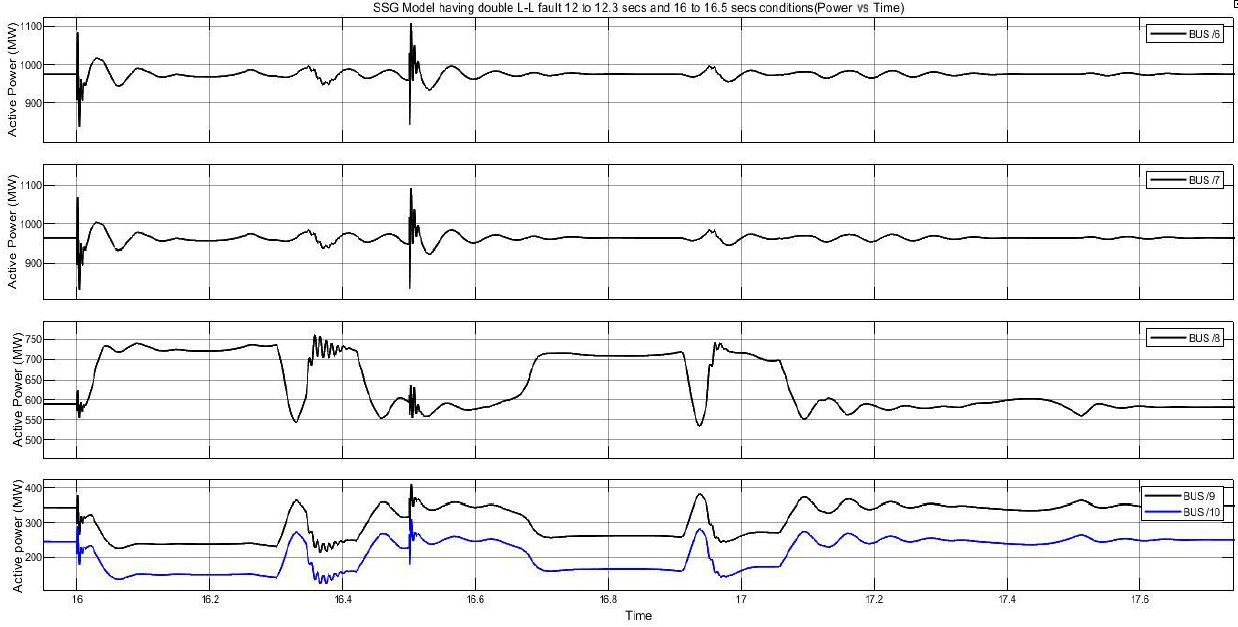
Figure 26. Multiple double line-to-line (L-L) faults are inserted in the system from 16 to 16.5 s (Bus 6 to Bus 10).